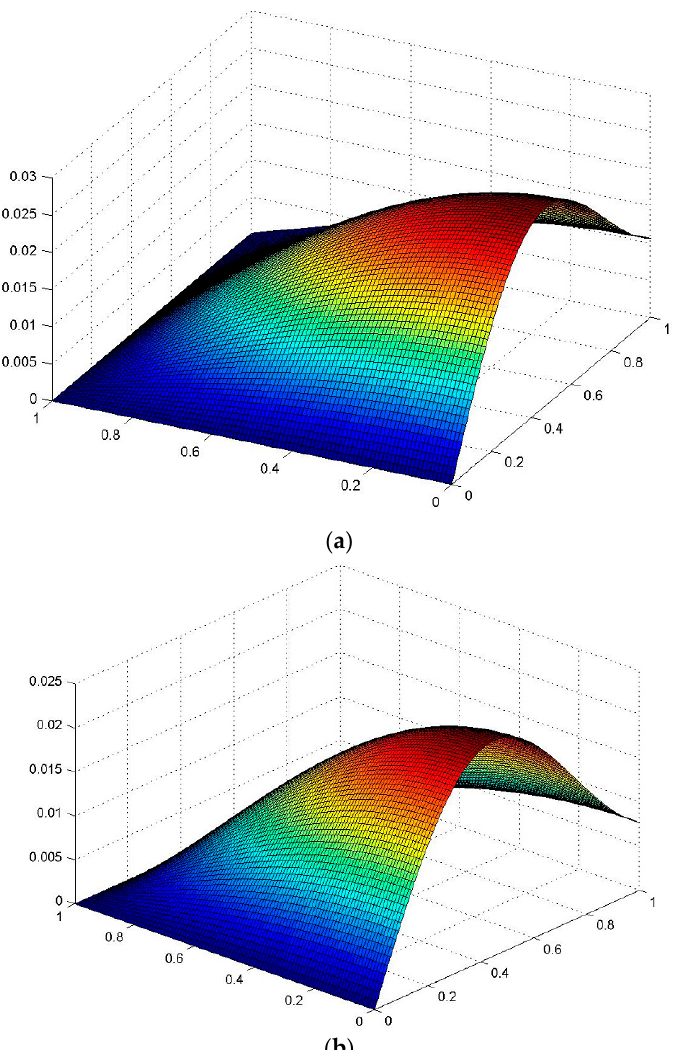
Figure 7. Vibration form of a rectangular plate at t = 130: ( a ) α ∗ = 0; ( b ) α ∗ = 0.3.